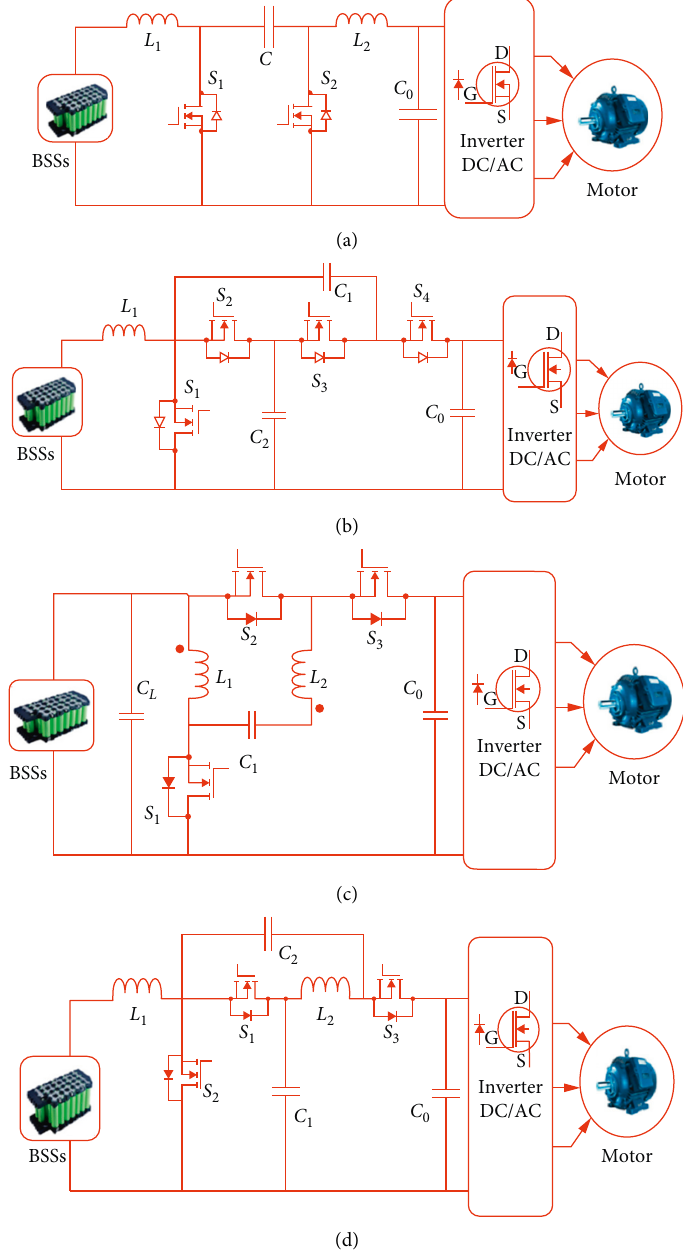
Figure 14: Various non-isolated DC-DC converters for EVs: (a) Cuk converter, (b) capacitor switched bidirectional converter, (c) bi- directional converter with couple inductor, and (d) quasi-Z-source